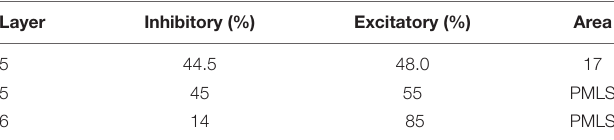
FIGURE 2 | Models and short-term plasticity for synapses used in this work. (A) Three models were used during simulations. All models contain a pulvinar structure with 80% of excitatory (red dots) and 20 % of inhibitory (blue dots) neurons as represented in the proportion of dots inside boxes. (A1) Pulvinar receives only terminal types 1 and 2. (A2) Two areas with proportion and number of contacts of terminal types 1 and 2 in areas 17 and 21a as described in Tables 1 , 2 . (A3) Cortico-pulvinar-cortical model consisting of three networks connected feedforwardly by cortico-cortical pathways and with a transthalamic pathway. A similar proportion of connections as in panel (A2) was used. (B) Short-term plasticity for a pulvinar neuron receiving terminal types 1 (B1) and 2 (B2) . Four input frequencies are tested (2, 5, 10, 20 Hz) for each terminal type. (C) EPSP amplitude (mV) as a function of repetitions for five frequency-dependent stimulation regimes and the two types of cortical terminals shown in (C1,C2) . Note that the result of the stimulation at 0.5 Hz (blue line) is shown here but not plotted in panel (B) .